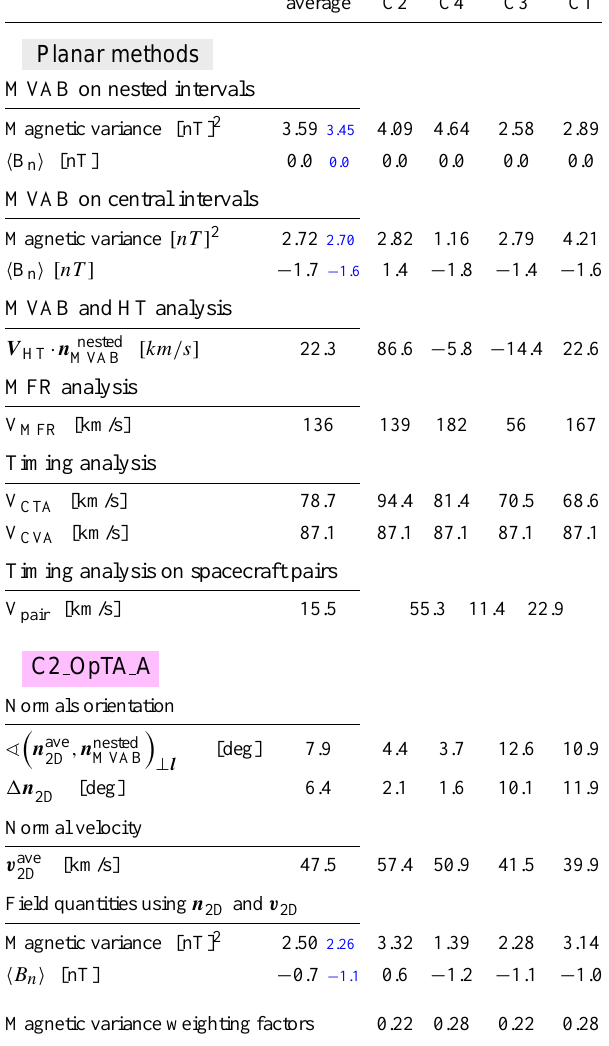
Table 3. Comparison between the C2 OpTA A solution and the planar results provided by MVAB, HT, MFR, and timing analysis techniques. Quantities corresponding to each satellite as well as average or global ones are shown. With smaller blue numbers, the global values of normal magnetic field variance and of h B n i based only on data from C1, C3 and C4 are indicated. More explanations are provided in the